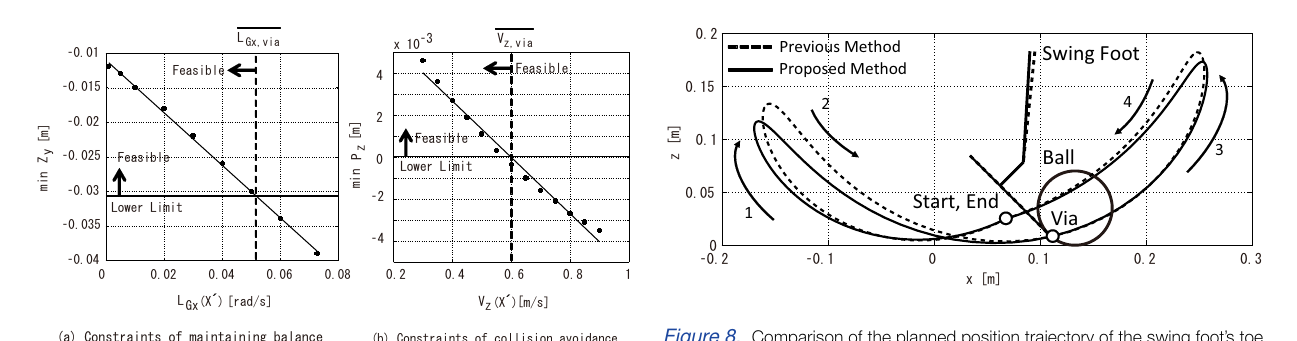
Figure 8. Comparison of the planned position trajectory of the swing foot’s toe in Environment 2 (solid line: trajectory using the proposed method; dotted line: trajectory using the previous method).